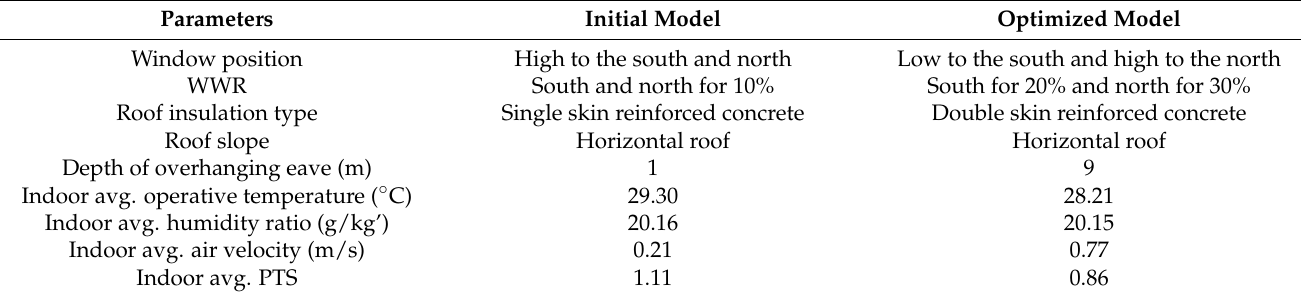
Table 7. Comparison of architectural forms and thermal performances between the initial model and the optimized model.